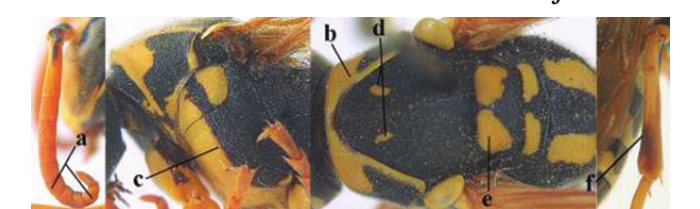
30 Antenna dorsally orange-yellow (a); pronotal transverse yellow band more or less widened (b); epicnemial ridge delicate but well-defined (c), sometimes re- duced in Peloponnesian populations; mesoscutum almost always with pair of medium-sized to large yellow spots (d), sometimes minute or absent; scutellar spots large (e); inner side of hind tibia often partly darkened (f); medial area of face narrower; N Italy to SE Europe, Turkey and Central Asia .................. ............................................................................. P. foederatus Kohl, 1898